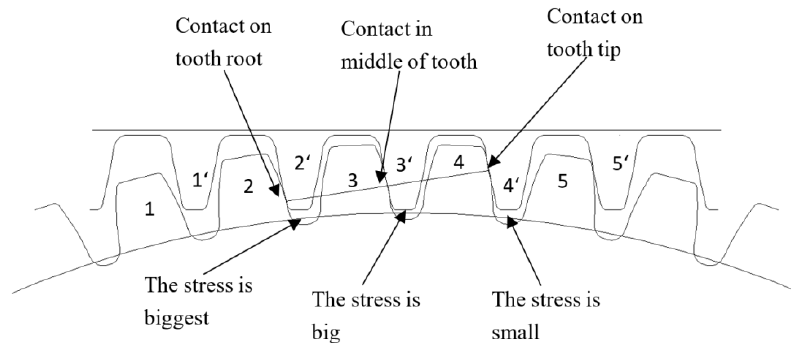
Figure 10. The distribution of stress for traditional meshing between steel worm and helical gear (a = b = c).